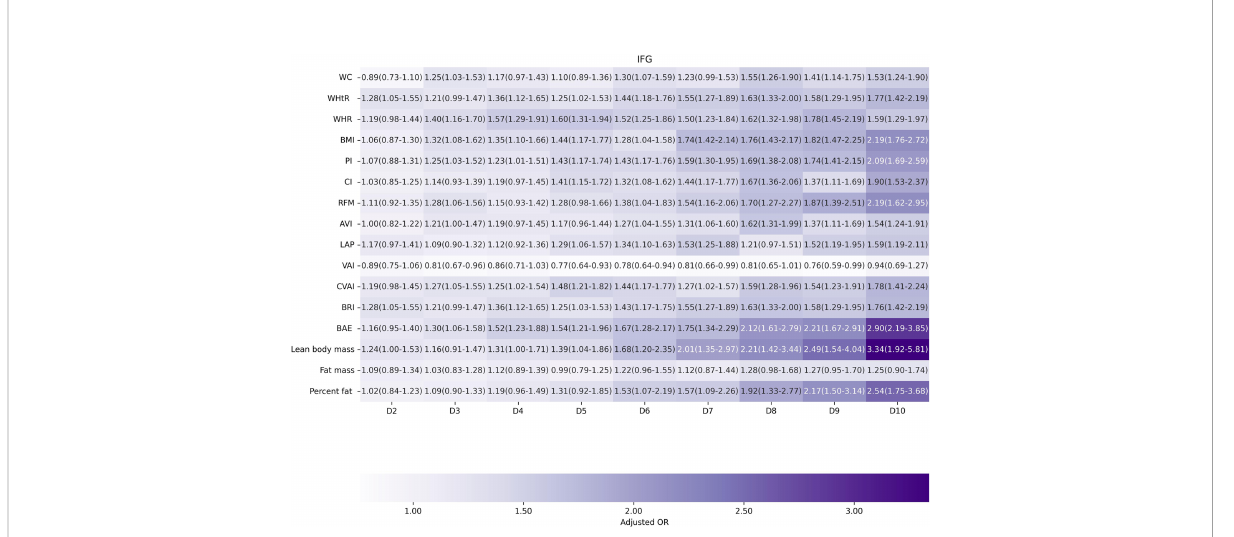
FIGURE 3 The association between deciles of obesity indicators and impaired fasting glucose. The fi rst decile (D1) was used as reference. Adjusted for age, gender, education level, equivalent household income, drug history, family history of diabetes, smoking status, drinking status, regular exercise, hypertension, TC, LDL-C, HDL-C, and TG; for lean body mass, fat mass and height were further adjusted; for fat mass, lean body mass and height were further adjusted. WC, waist circumference; WHtR, waist-to-height ratio; WHR, waist-to-hip ratio; BMI, body mass index; PI, ponderal index; CI, conicity index; RFM, relative fat mass; AVI, abdominal volume index; LAP, lipid accumulation product; VAI, visceral adiposity index; CVAI, Chinese visceral adiposity index; BRI, body roundness index; BAE, body adiposity estimator.